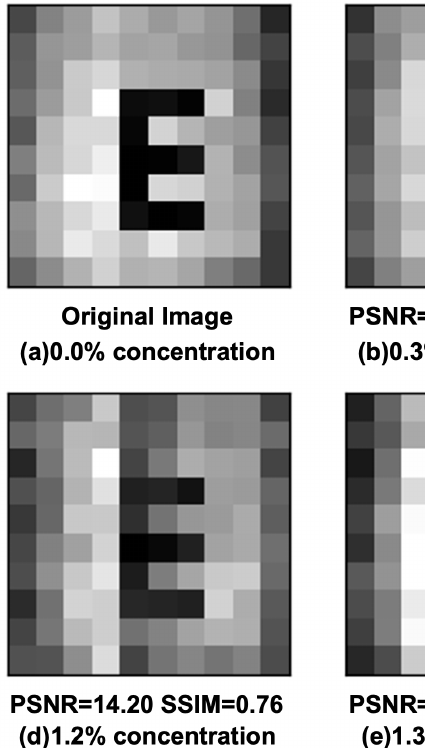
Figure 5. The results of each concentration solution (diluted milk) by DPGI methods in 2400 mea-